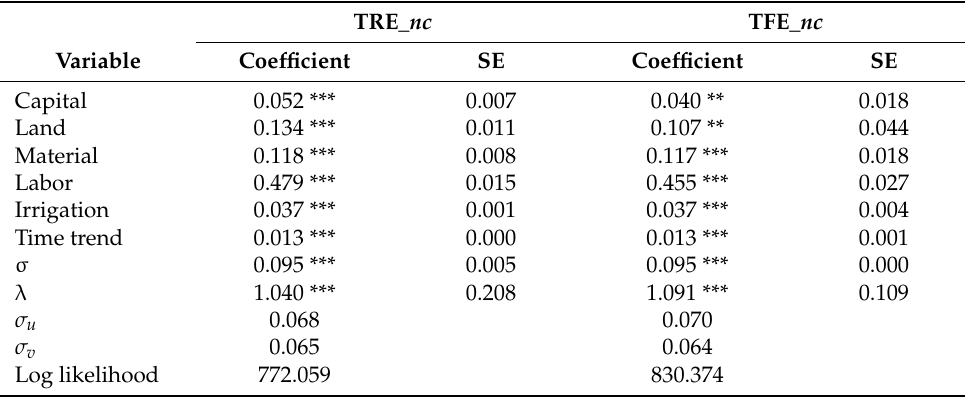
Table 2. Estimates for SPF models without climatic factors (N =